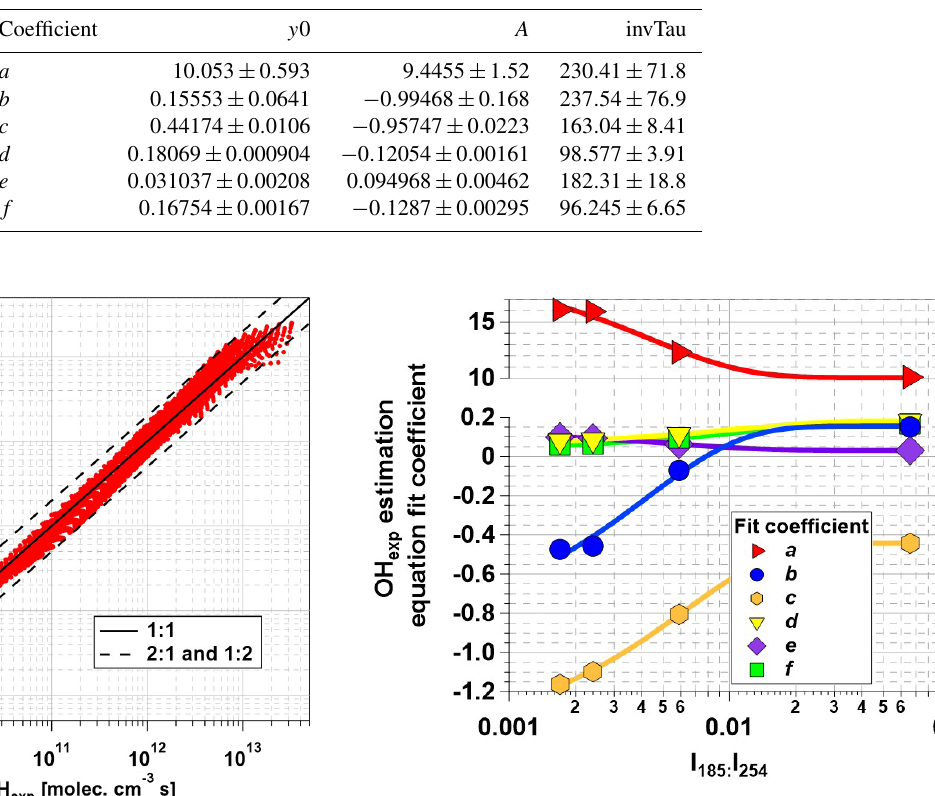
Figure 5. OH exp calculated from the estimation equation (Eq. 1) as a function of OH exp calculated from the full OFR185 KinSim mechanism (Table S1) for lamp types A and B. Solid and dashed lines correspond to the 1 : 1 and the 1 : 2 and 2 : 1 lines, respectively. Estimation equation fit coefficients are shown in Table 2.